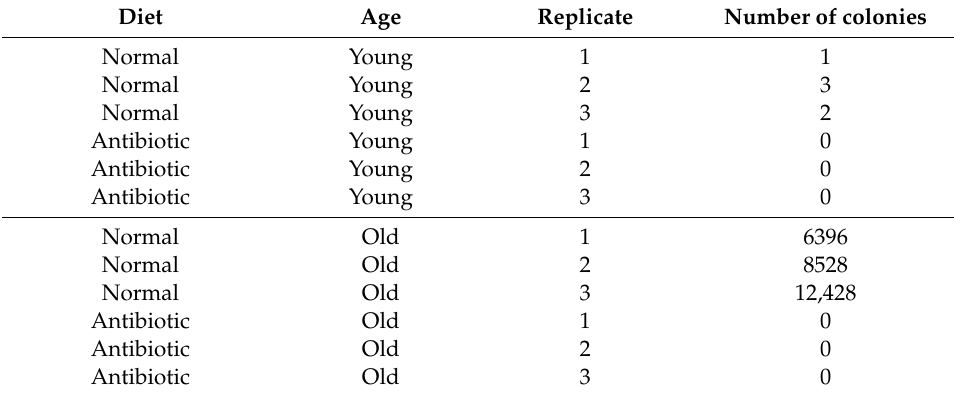
Table 1. Bacterial colony counts of the whole gut from male flies of both old and young ages, from both normal and antibiotic-supplemented diets.